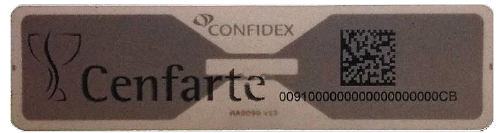
Figure 2. Confidex’s Carrier Tough passive